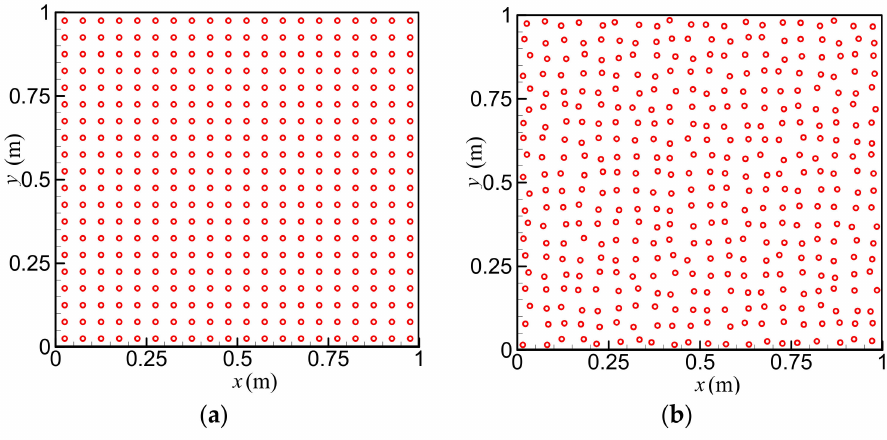
Figure 1. Particle distributions with the particle number of 400: ( a ) under uniform distribution; and ( b ) under non-uniform